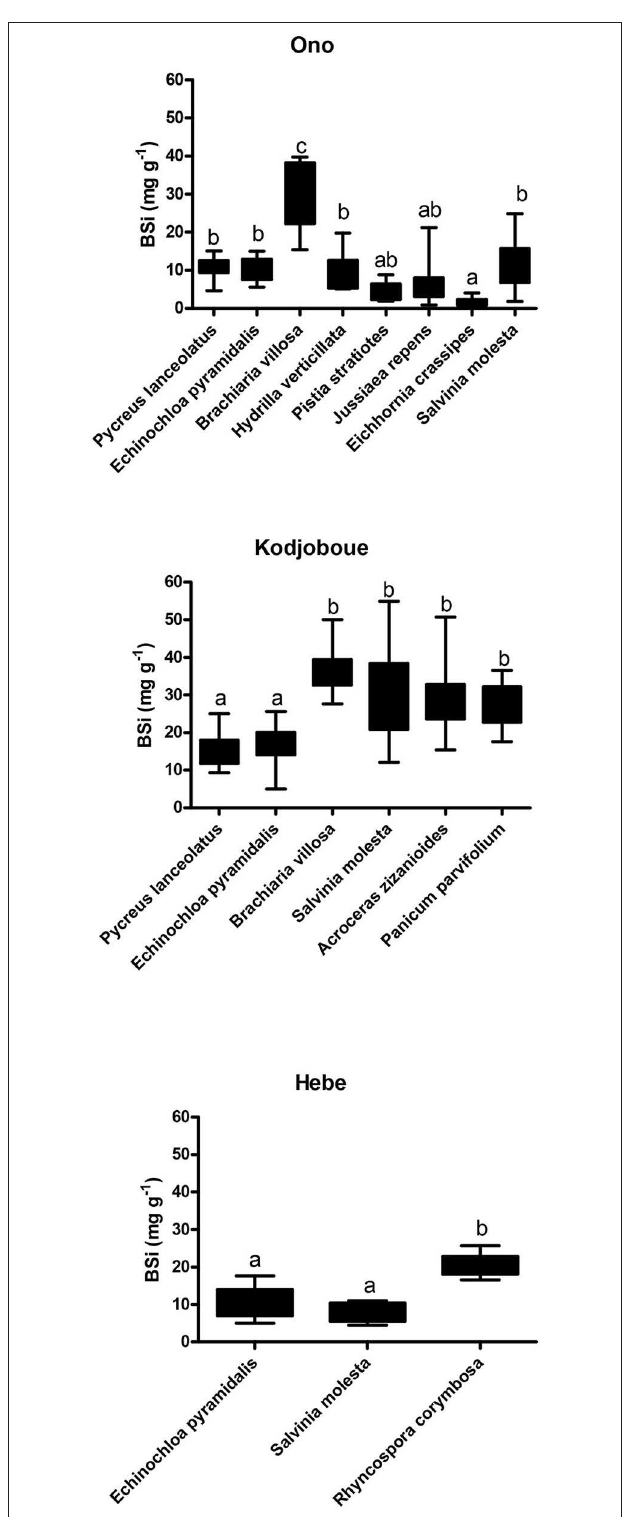
FIGURE 3 | Box-plots showing average BSi concentrations in the different macrophytes for the three lagoons. The vertical bars refer to the minimum/maximum values and the different letters indicate a significant difference ( p <